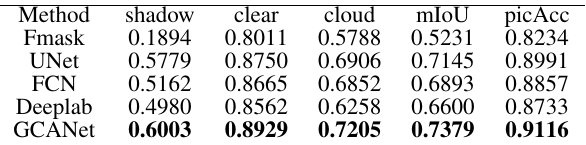
Table 1. Results of the first group of experiments. The 2-4 columns denote the IoU of each class